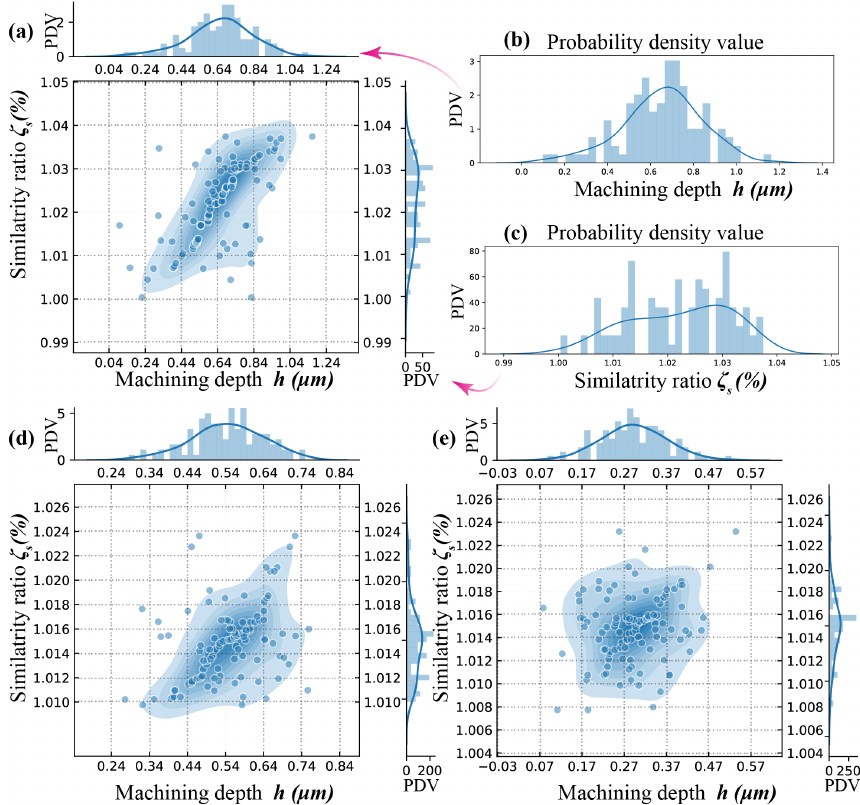
Figure 7. Distribution of similarity ratio ζ s and machining depth h with different nozzle speed at applied voltage U = 50 V : ( a ) v 1 = 800 µ m/s; ( b ) distribution of machining depth h ; ( c ) Distribution of similarity ratio ζ s ; ( d ) v 2 = 2400 µ m/s; ( e ) v 3 = 4800 µ